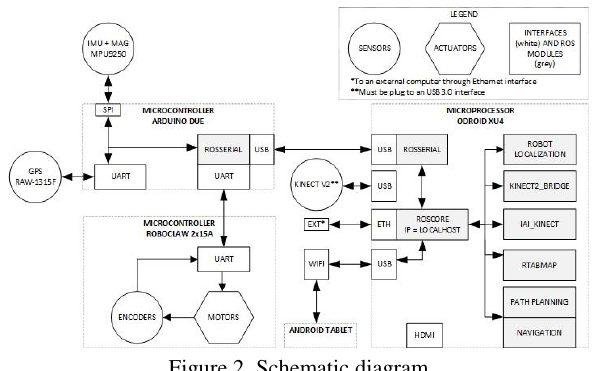
Figure 2. Schematic